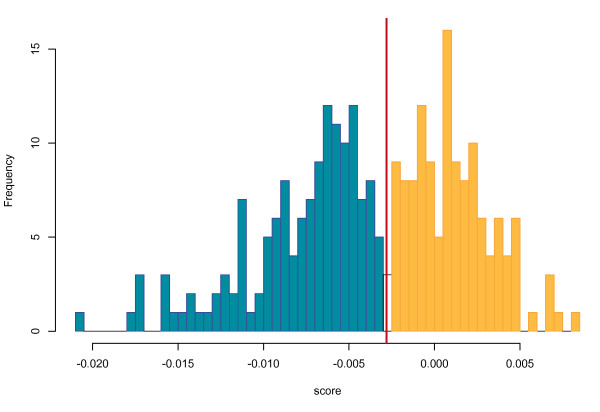
Distribution of the average prediction score of gene deserts. The red line corresponds to the threshold below which a region is considered refractory. The distribution is clearly bimodal, as highlighted by the coloring scheme.